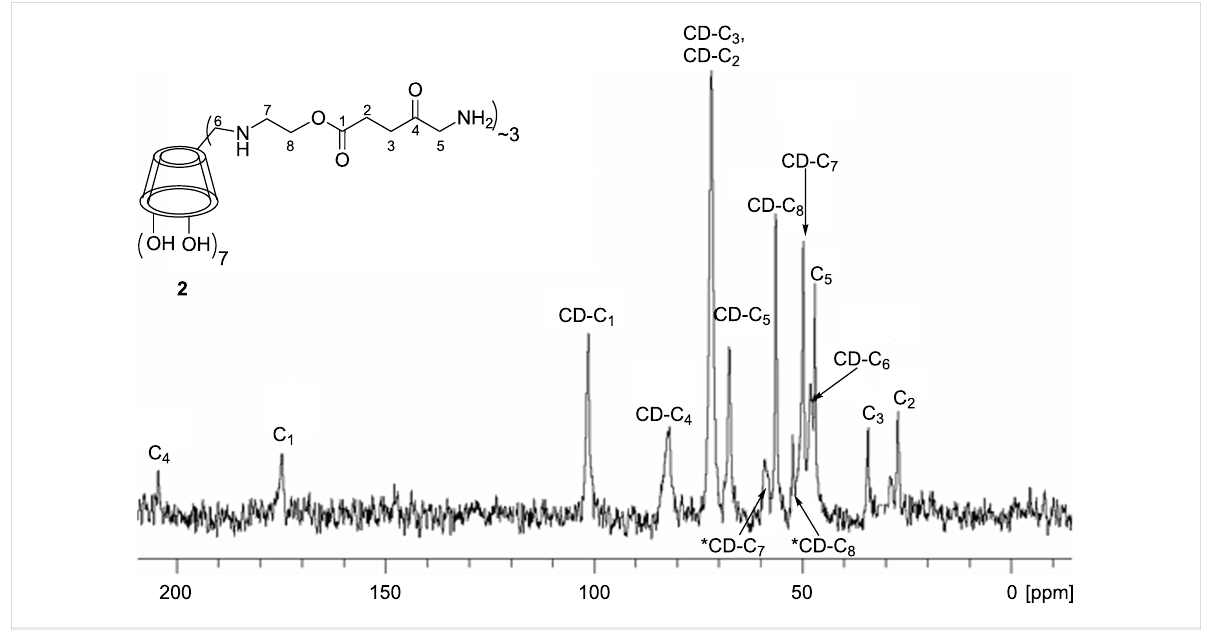
Figure 1: 13 C NMR spectrum of 2 (D 2 O, 125 MHz) with assignment of the peaks.